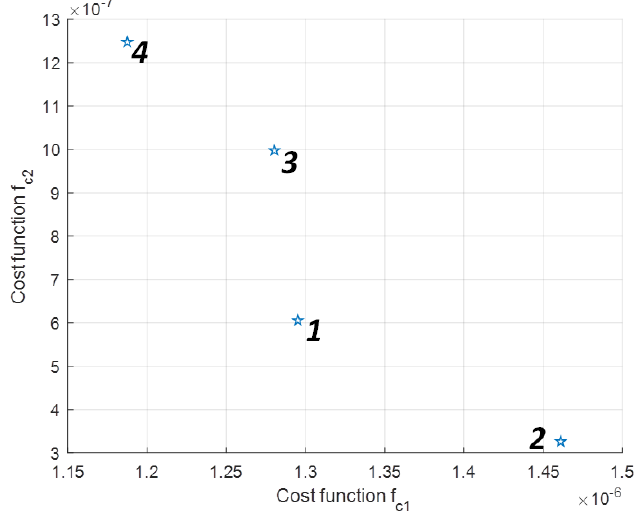
Figure 8. MOGA optimal solutions considering the constraints N r = 5 (maximum of 5 repetitions of the same tray are allowed in the rack).